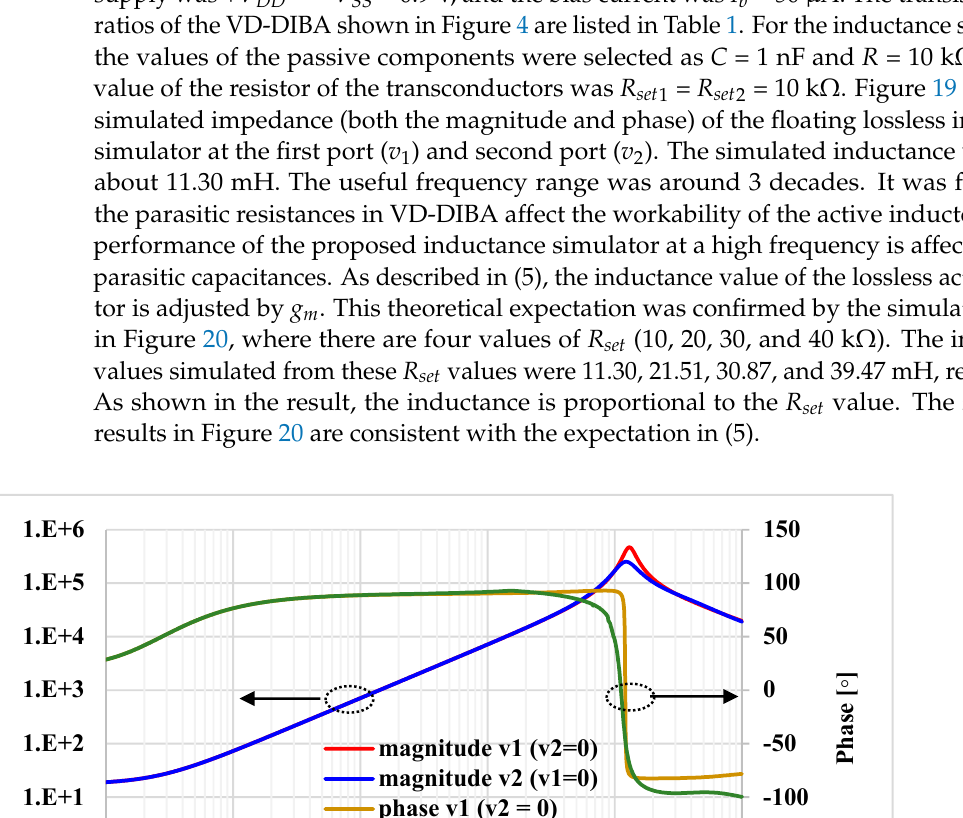
Figure 20. The frequency responses of the lossless L connection with different R set . The simulated impedance (both the magnitude and phase) of the floating inductance- resistance simulator with R set = 10 k Ω is shown in Figure 21. The simulated inductance and resistance values are about 12.39 mH and 9.22 k Ω , respectively. The impedance of the floating series L-R for different values of R set is shown in Figure 22, where R set had four values (10, 20, 30, and 40 k Ω ). The inductance values simulated from these R set values were 12.39, 23.38, 30.92 and 35.29 mH, respectively. Additionally, the resistance values simu- lated from these R set values were 9.22, 16.88, 23.41, and 29.04 k Ω , respectively. The simu- lation performed on the floating parallel inductance-resistance simulator is shown in Fig- ure 23. The simulated inductance and resistance values were about 11.28 mH and 9.43 k Ω , respectively. The impedance of the floating parallel L-R for different values of R set is shown in Figure 24, where R set was changed to four values (10, 20, 30, and 40 k Ω ). The inductance 1.E+11.E+2 1.E+31.E+4